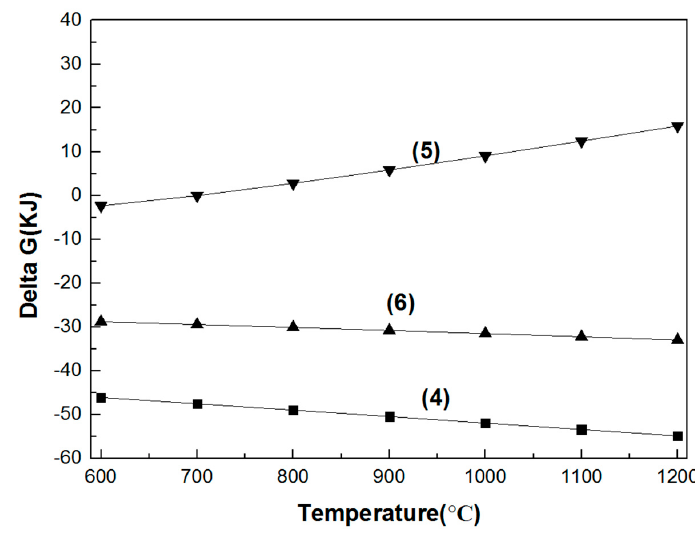
Figure 5. Gibbs free energy of the synthesis reaction of the three spinels in the 600–1200 °C temperature range. (4) MgO + Cr 2 O 3 = MgO·Cr 2 O 3 ; (5) MgO + Fe 2 O 3 = MgO·Fe 2 O 3 ; (6) MgO + Al 2 O 3 = MgO·Al 2 O 3 .